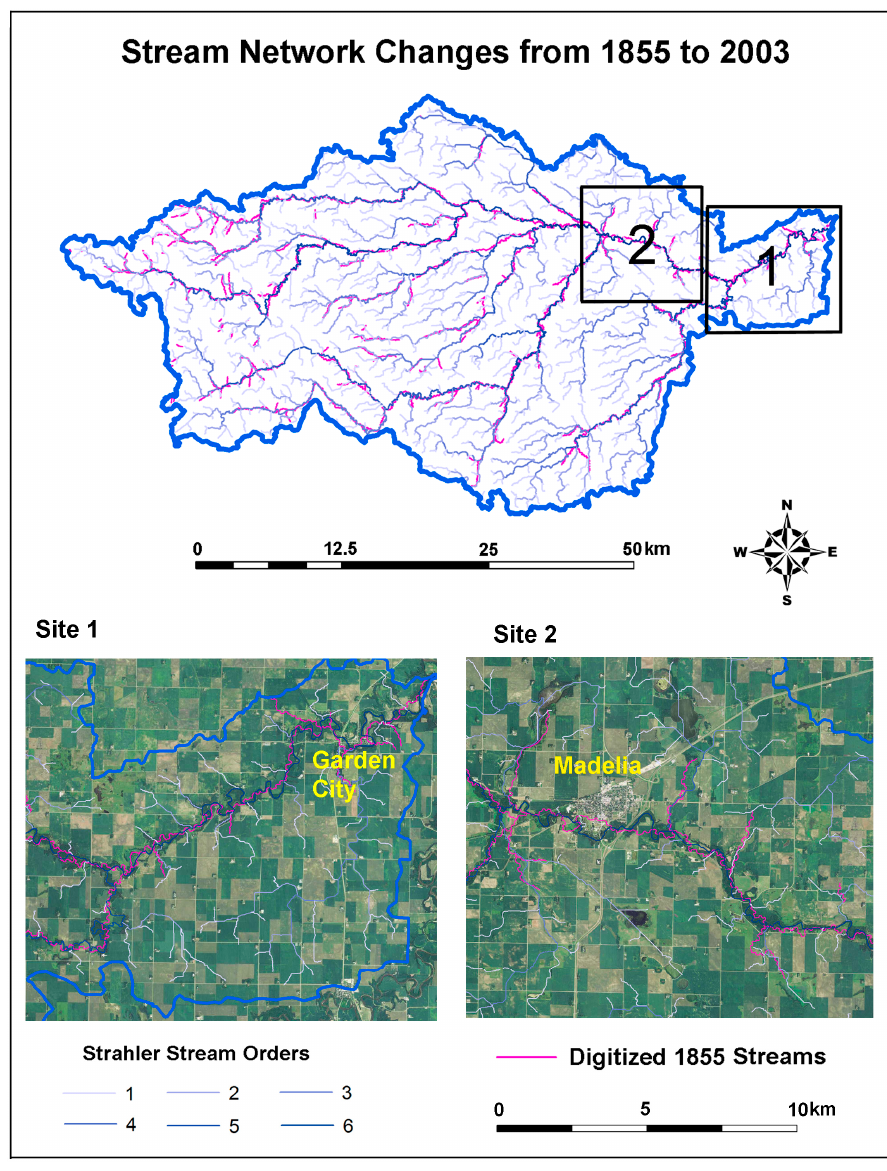
Figure 6. Stream network changes.